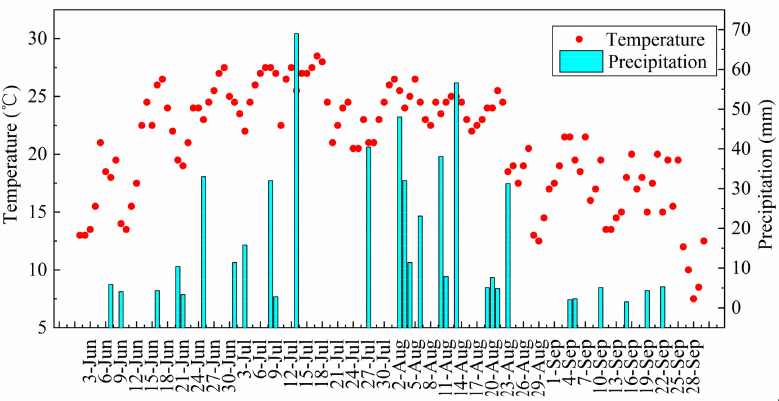
Figure 1. Temperature and precipitation from June to September